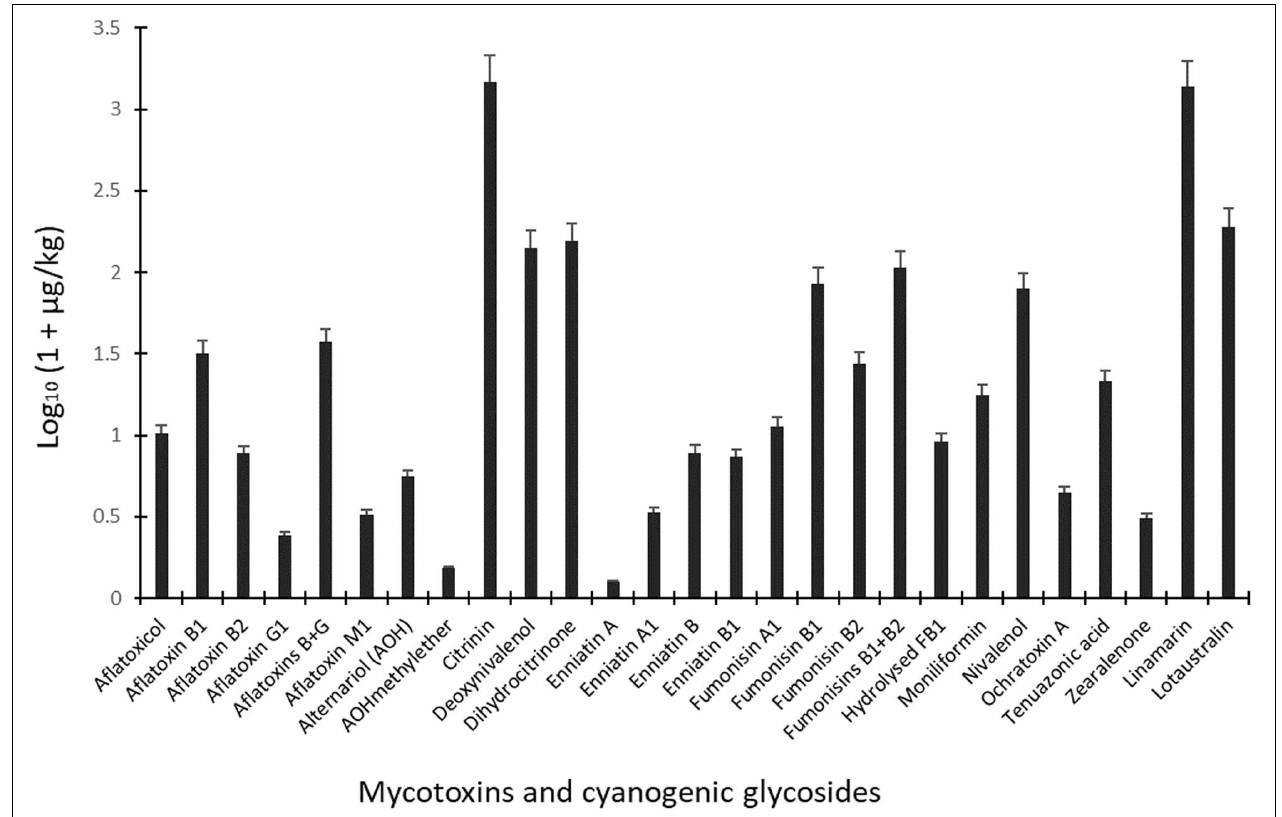
FIGURE 3 | Mean levels of mycotoxins and cyanogenic glycosides in dried ready-to-eat foods vended in markets in Ogun State, Nigeria. Ochratoxin B was not included in the graph due to occurrence in only one